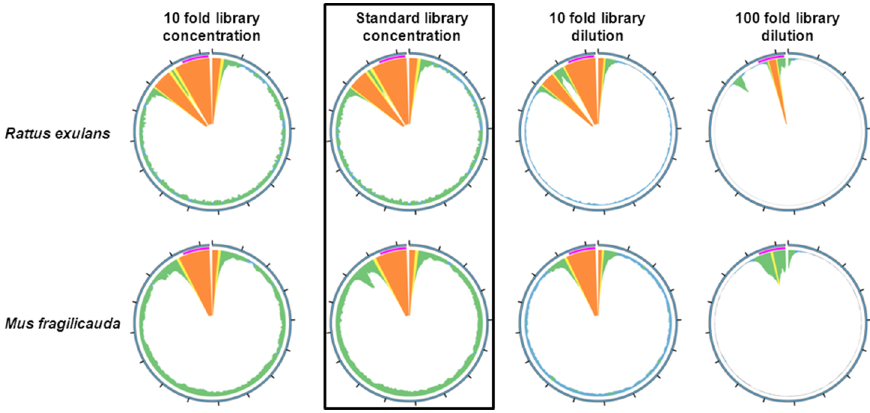
Figure 1. Effect of library concentration on CapFlank. Four dilutions of an Rattus exulans and Mus fragilicauda Illumina genomic DNA library were prepared. The dilution series was enriched for the control region using an 1040 bp mitochondrial DNA control region PCR product bait sheared to average size of 250 bp generated from Mus caroli , Mus cervicolor , Mus cookii , Mus fragilicauda , Rattus norvegicus and Rattus exulans . and the reads assembled to the Rattus exulans or Mus musculus mitochondrial genome reference (GenBankNC_012389.1, EF108336.1) for Rattus exulans and Mus fragilicauda respectively. The standard dilution results (1.5 m g input library) are emphasized with a box around both the Rattus exulans and Mus fragilicauda results. The region covered by the bait is indicated as a magenta bar. Mapping results at depths over 10,000 per bp, 1,000 per base, 500 per base, 50 per base are shown in orange, yellow, green and blue respectively. The data demonstrate that the more dilute the input library used, the lower the enrichment of sequences flanking the target becomes.